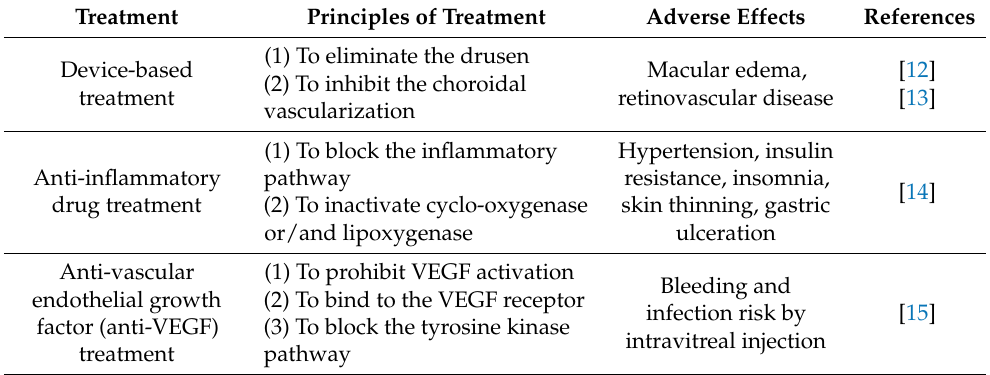
Table 1. Current treatments for age-related macular degeneration and the adverse effects of each